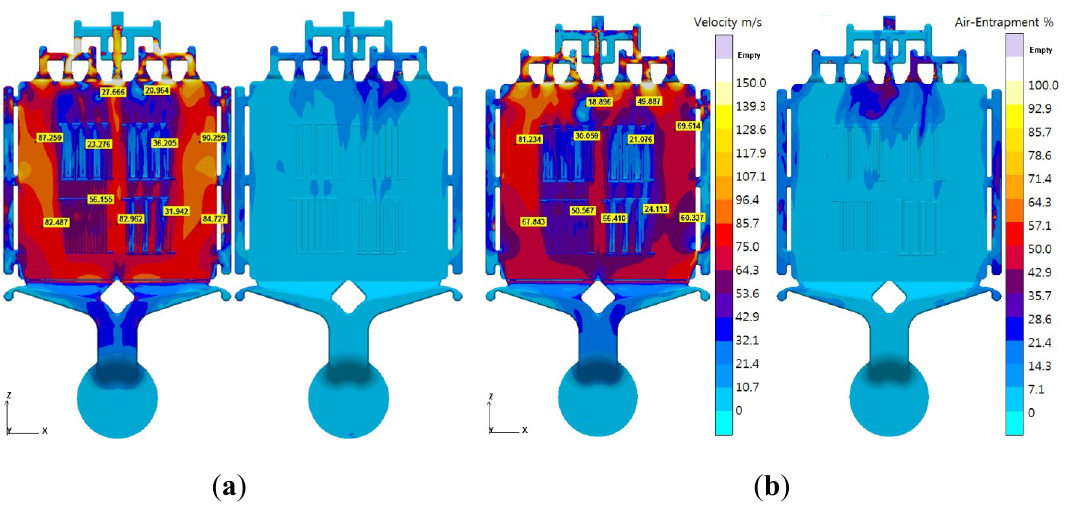
Figure 7. Velocity distribution of the melt and air content in the die cavity using different plunger speeds in vacuum die-casting: ( a ) 3.0 m/s and ( b ) 2.5